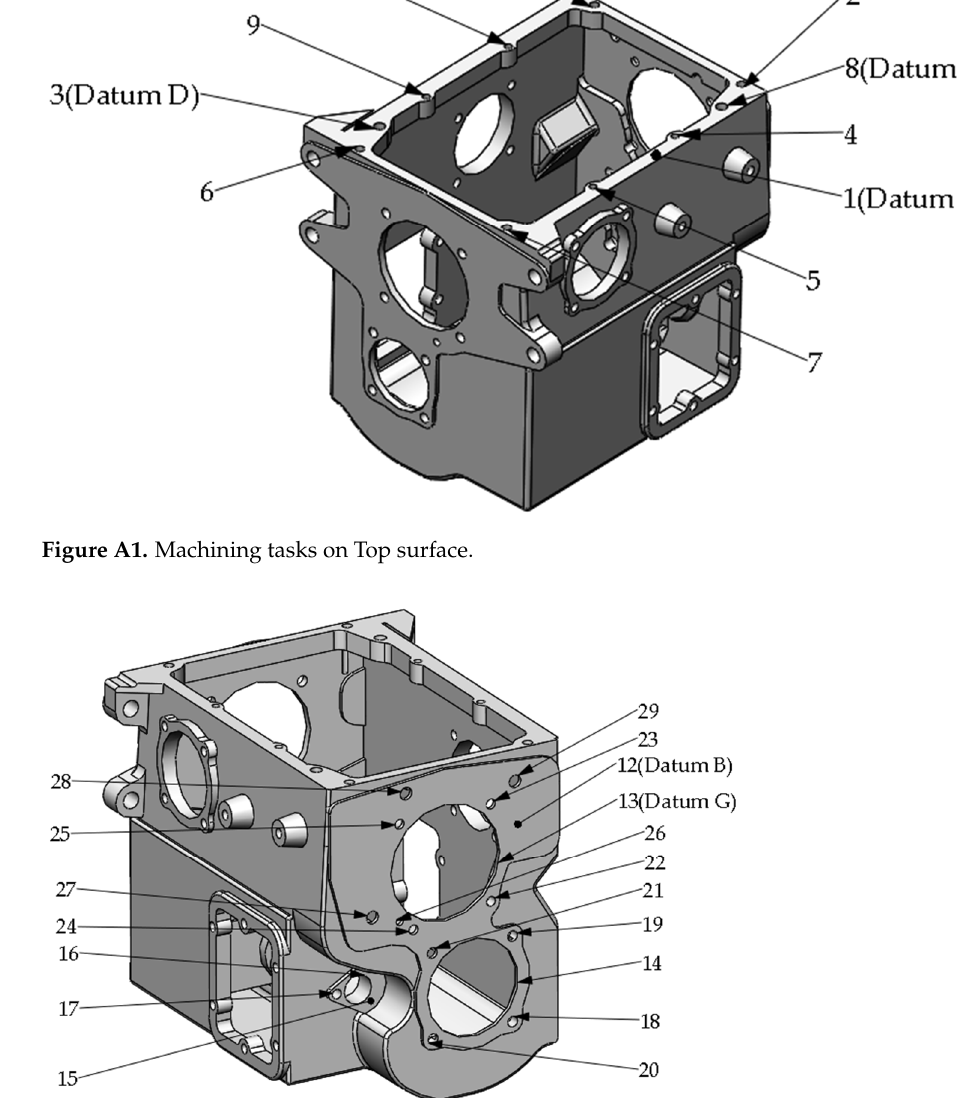
Figure A3. Machining tasks on Rear surface. Figure A4. Machining tasks on Left surface.